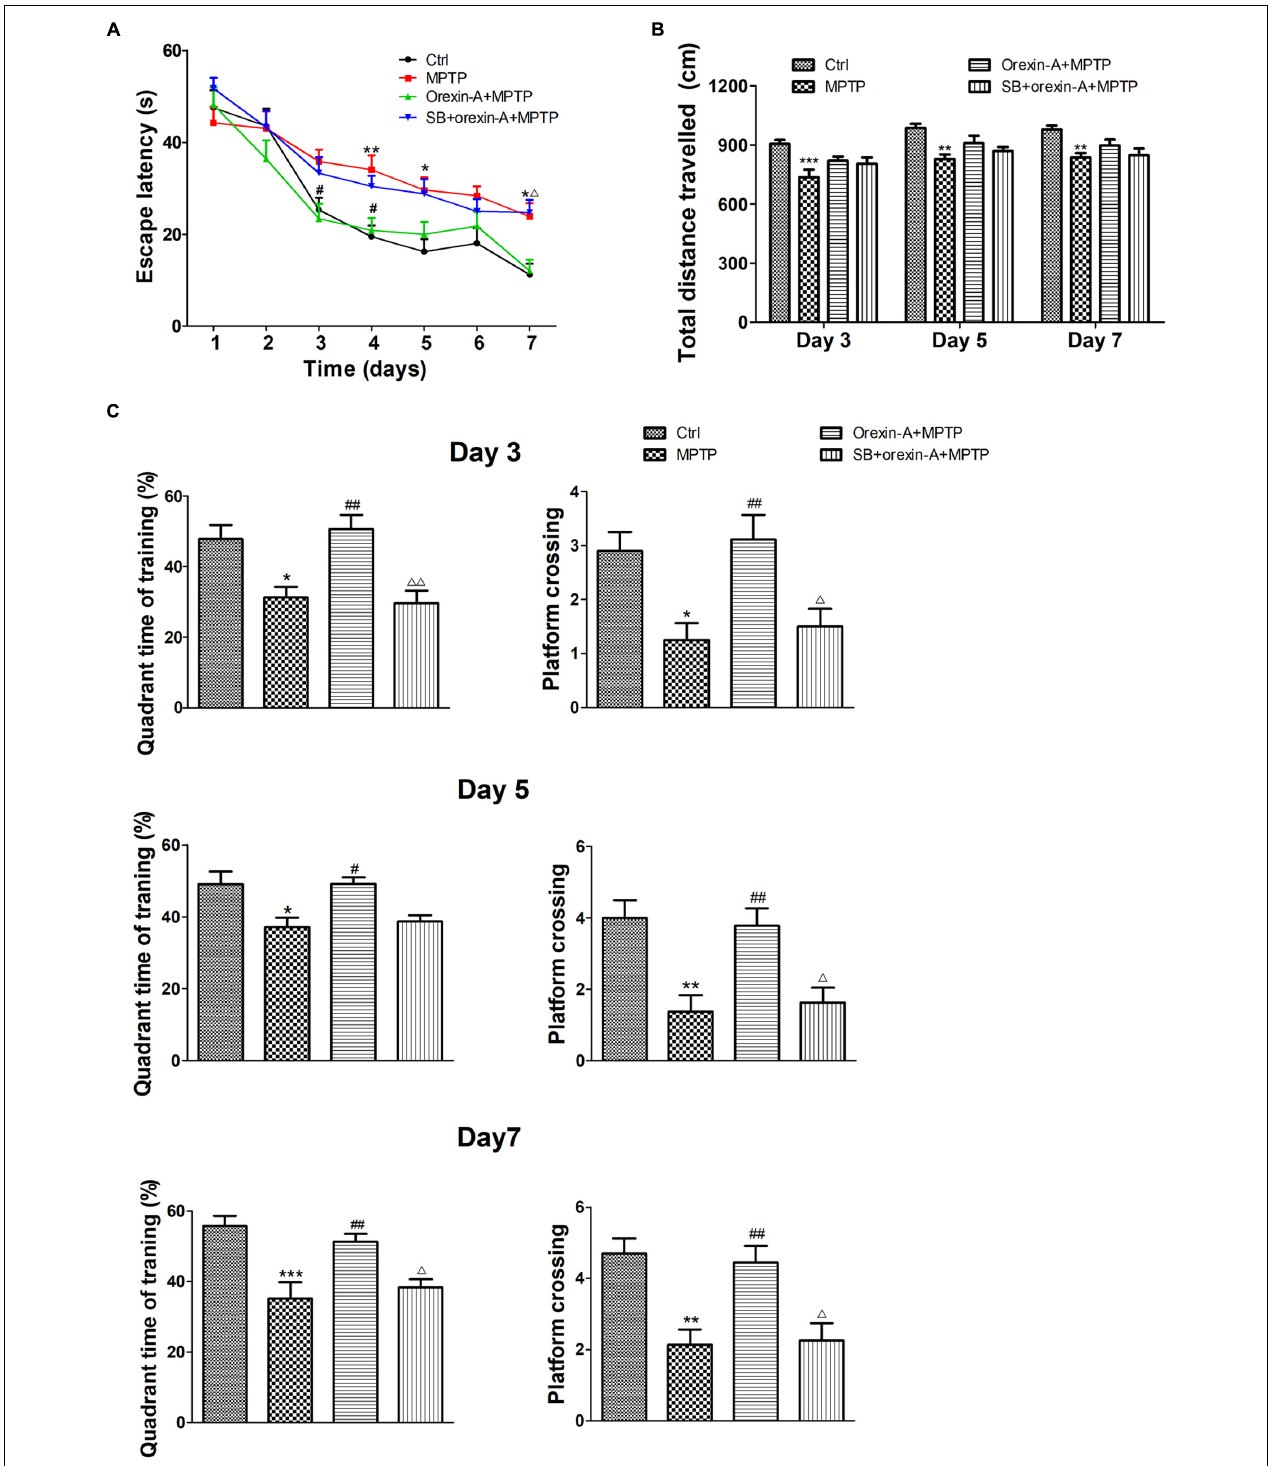
FIGURE 4 | Effects of orexin-A on MPTP-induced impairments in spatial learning and memory. (A) Effects of orexin-A on escape latency at the training session. (B) Total distance traveled in the probe test on day 3, day 5, and day 7 of training. (C) Two hours after the second training trial, retention of memory was tested in the 60 s probe trial on day 3, day 5, and day 7 of training session, separately. Each value represented mean ± SEM, n = 8–10. ∗ P < 0.05, ∗∗ P < 0.01, ∗∗∗ P < 0.001 vs. control; # P < 0.05, ## P < 0.01 vs. MPTP; (cid:49) P < 0.05, (cid:49)(cid:49) P < 0.01 vs. orexin-A + MPTP. SB: SB334867.